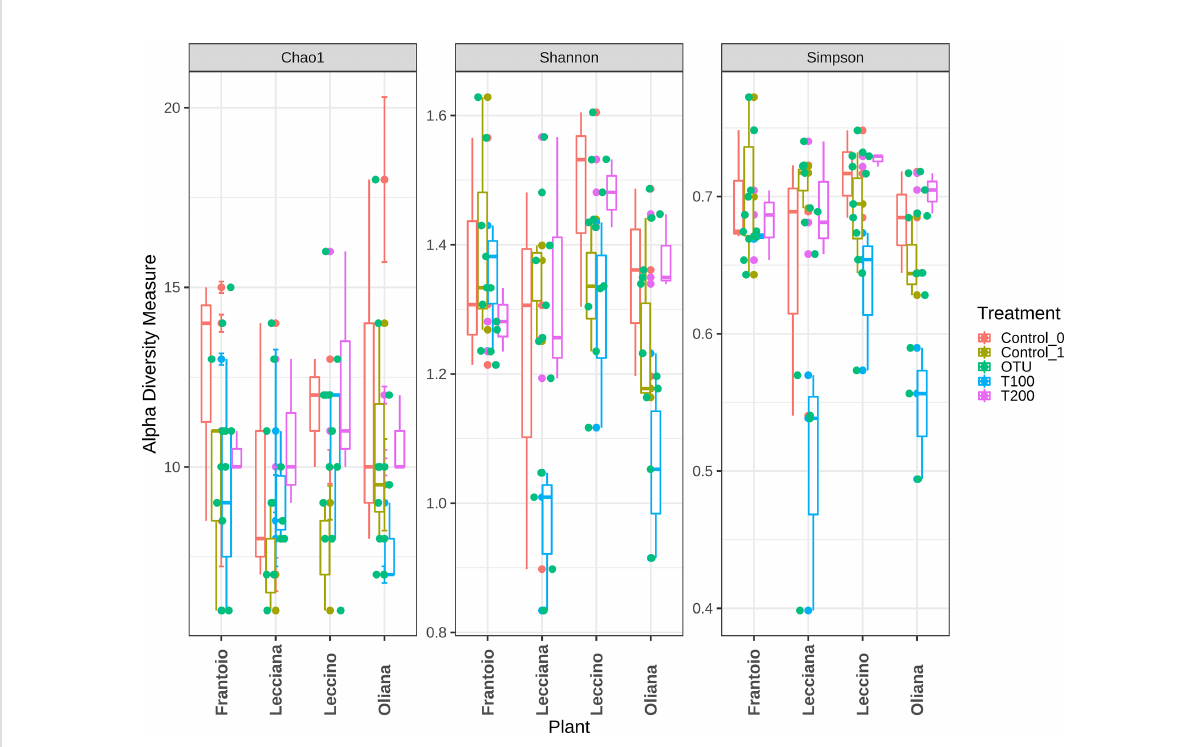
FIGURE 4 Alpha diversity assessment within analyzed samples. Data were computed based on three different indexes, Chao1, Shannon, and Simpson. Represented data show the diversity within each